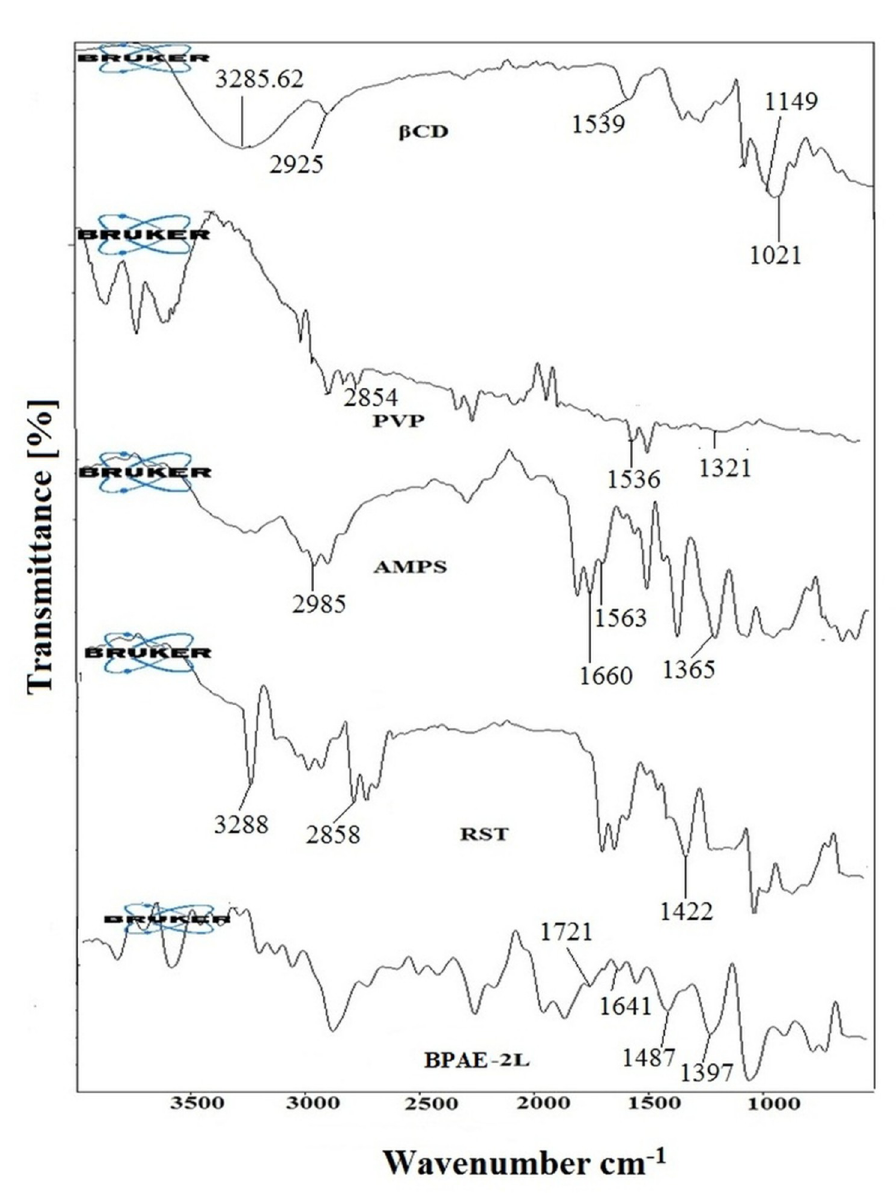
Fig 2. FTIR spectra of β CD, PVP, AMPS, rosuvastatin and loaded (PBCD-2L) fabricated nanogels indicating the peak shifting due to crosslinking. shows CH stretching characteristics peaked at 2854.23 cm -1 . The stretching of the carbonyl group (C = O) was noticed as a prominent peak at 1536.35 cm -1 . The amide band III (C–N stretch) had a significant peak at 1321.01 cm -1 . The structural peaks in the FTIR spectra of AMPS were 1660.41 cm-1 and 1563.94 cm -1 , respectively, showing C = O stretching (Amide I band) and N-H bending (Amide II band). The presence of the SO H group in AMPS was con- 3 firmed by characteristic peaks at 1236.09 cm -1 and 1365.51 cm -1 , which showed symmetrical and asymmetrical stretching of the S = O group. The spectral peak at 2985.66 cm -1 revealed C-H stretching of-CH . The S-O-C group is represented by a prominent absorption band in 2 the range of 1077.85 cm -1 to 832.75 cm -1 [13–41]. The peaks at 3282, 2858, and 1422.45 cm -1